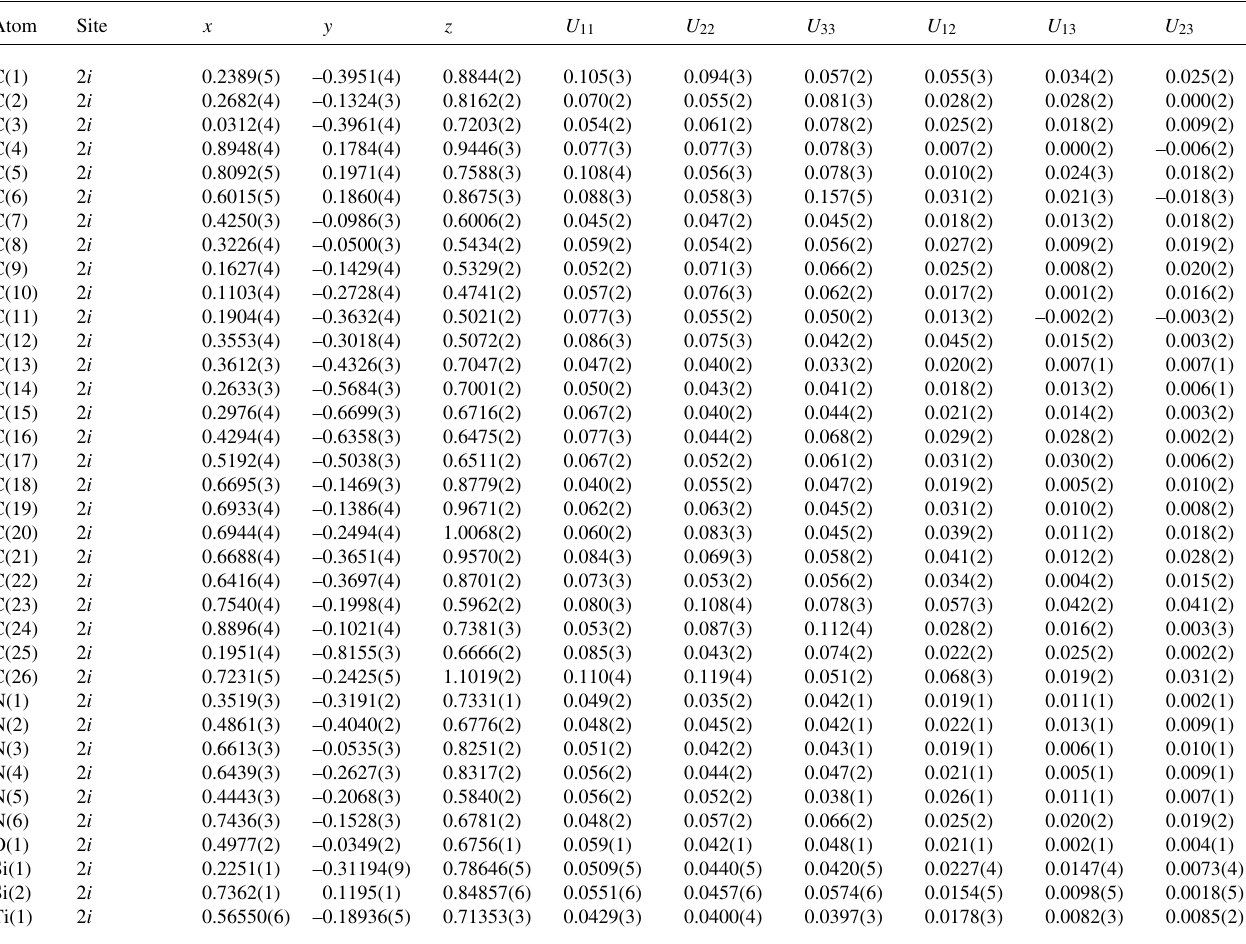
Table 3. Atomic coordinates and displacement parameters (in Å 2 )